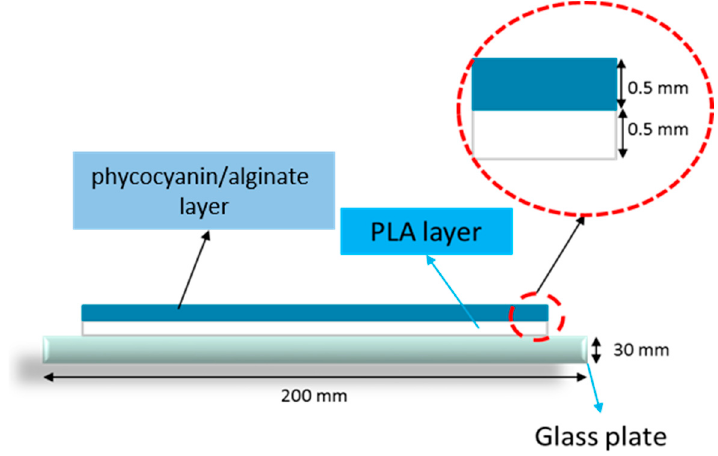
Figure 1. Schematic diagram of two layers of the composite.